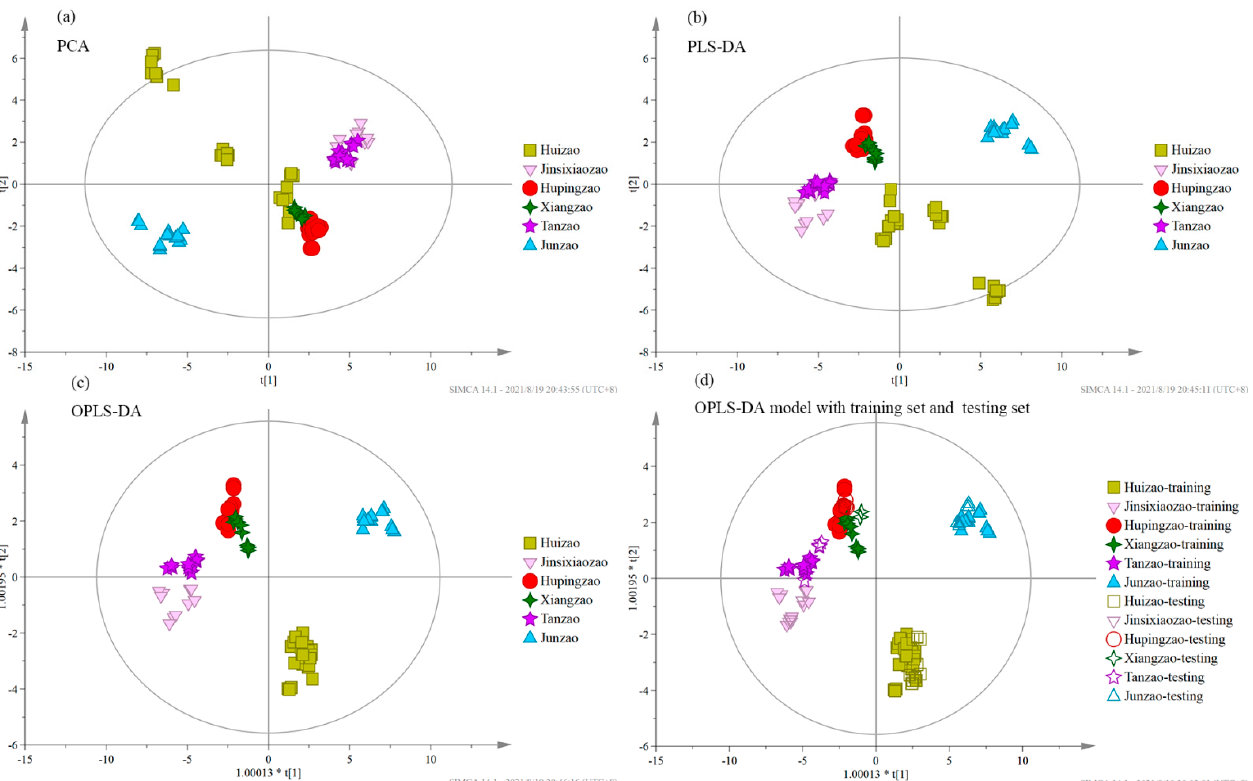
Figure 4. Principal component analysis (PCA), partial least squares-discriminant analysis (PLS-DA), and orthogonal partial least squares-discriminant analysis (OPLS-DA) of Chinese jujube samples in six varieties with the eight main quality parameters, and the OPLS-DA model of the six categories of Chinese jujubes samples with the training set and testing set: ( a ) PCA; ( b ) PLS-DA; ( c ) OPLS-DA; ( d ) OPLS-DA model with training set and testing